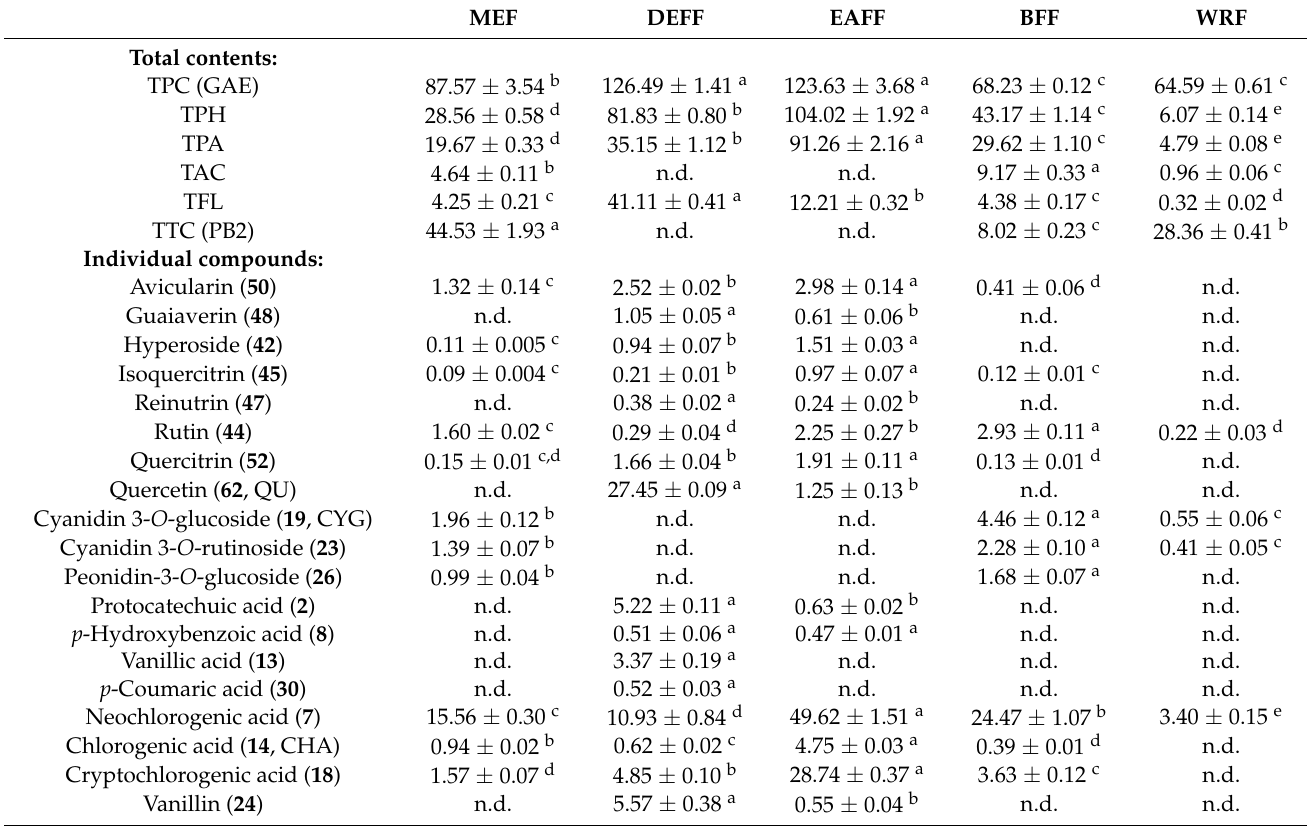
Table 1. Quantitative profile of the P. spinosa fruit extracts (mg/g dw). MEF DEFF EAFF